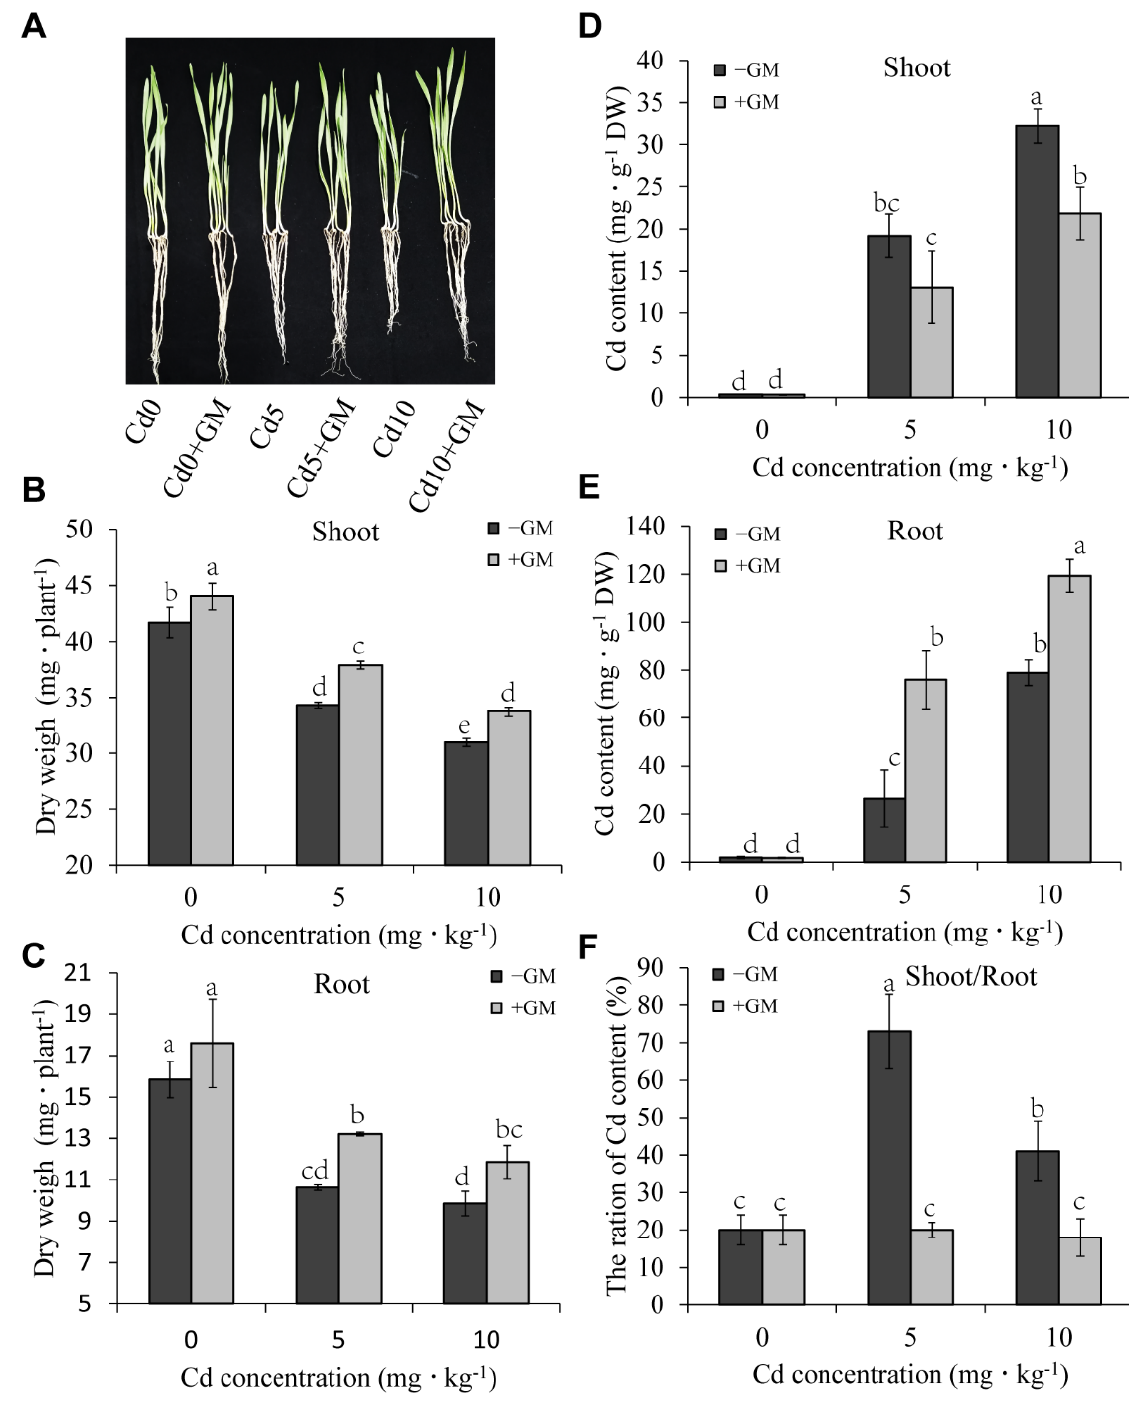
Figure 1. Effects of AMF on wheat growth and Cd content under Cd stress. The changes of phenotype ( A ), dry weight of shoots ( B ) and roots ( C ), Cd content in shoots ( D ) and roots ( E ), and its ratio in shoots/roots ( F ) under Cd stress. Values are the means ± standard deviation (SD) ( n = 3). Different letters in the same column indicate statistically significant differences ( p < 0.05).